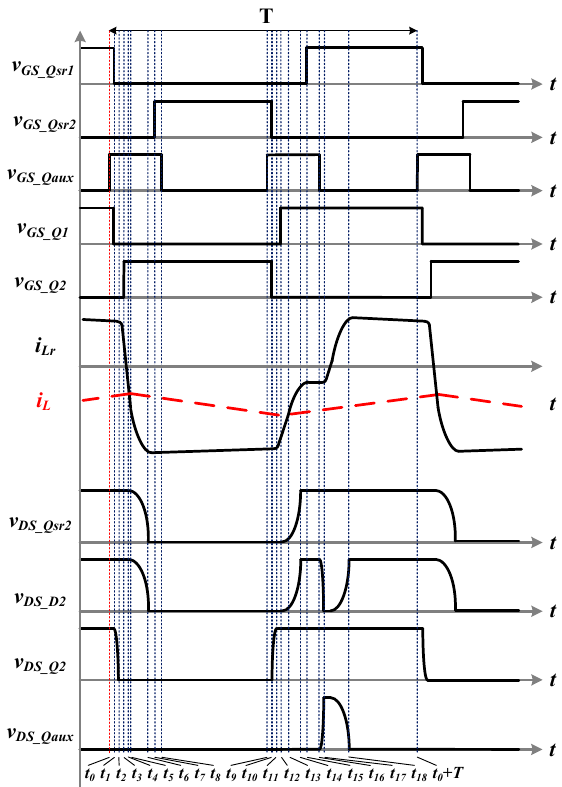
Figure 10. Bilateral ZVS synchronous rectified step-down converter operation waveform (reverse mode).